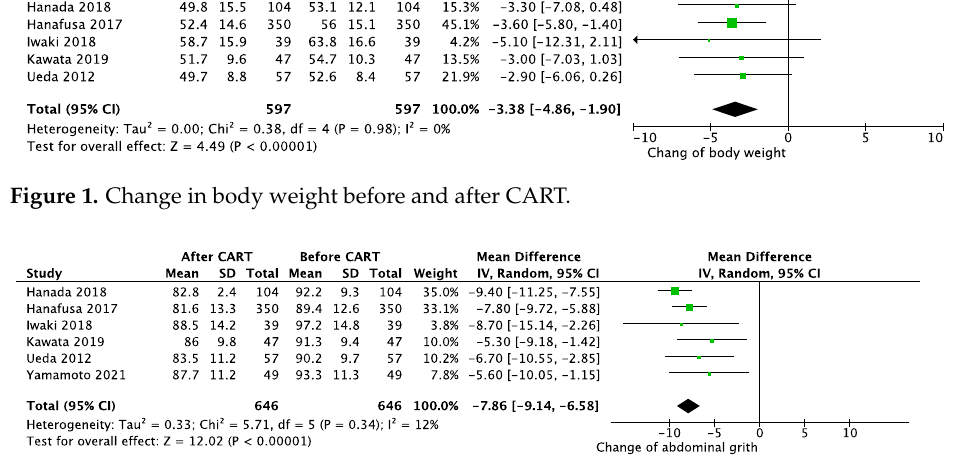
Figure 2. Change in abdominal circumference before and after CART.